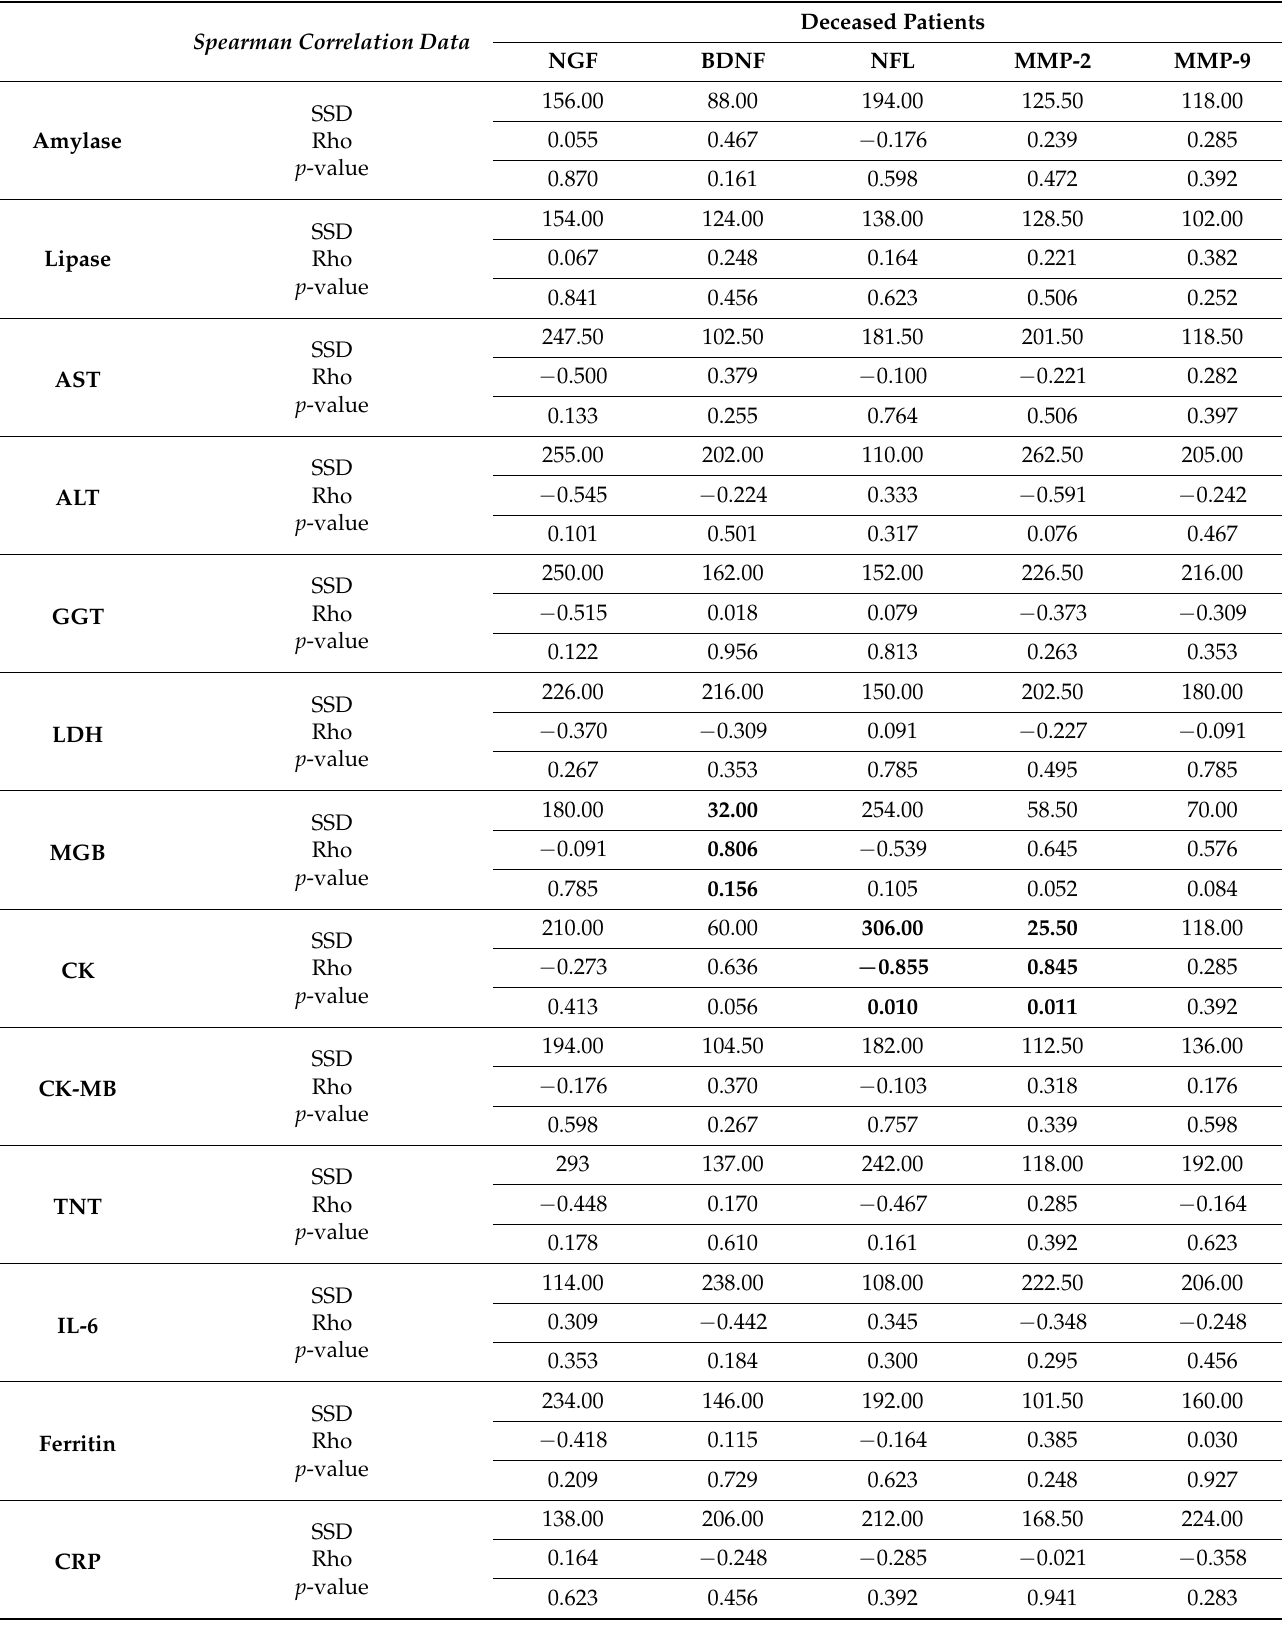
Table 5. Spearman correlations of the individuals of the deceased group between the blood parameters and NGF/BDNF/NFL/MMP-2/MMP-9. Significant scores are shown in